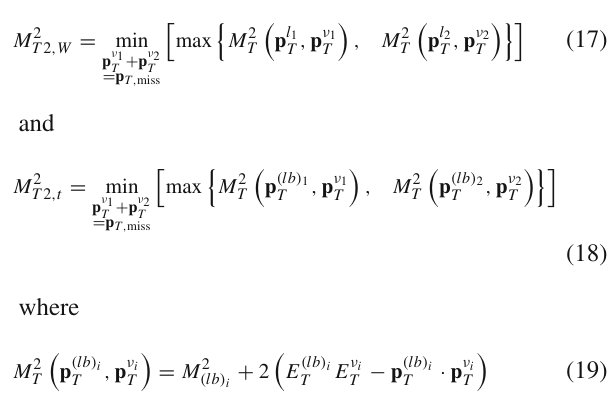
Fig. 3 Production cross section for pp → b ¯ be + μ − ν e ¯ ν μ χ ¯ χ for scalar and pseudoscalar mediators depending on the mass m Y of the mediator. The results have been generated using MadGraph5_aMC@NLO for the LO/NLO production and MadSpin for the (LO) decays with the respective LO and NLO CT14 PDF sets and a central scale μ DM E T / 3 for the LHC with center of mass energy